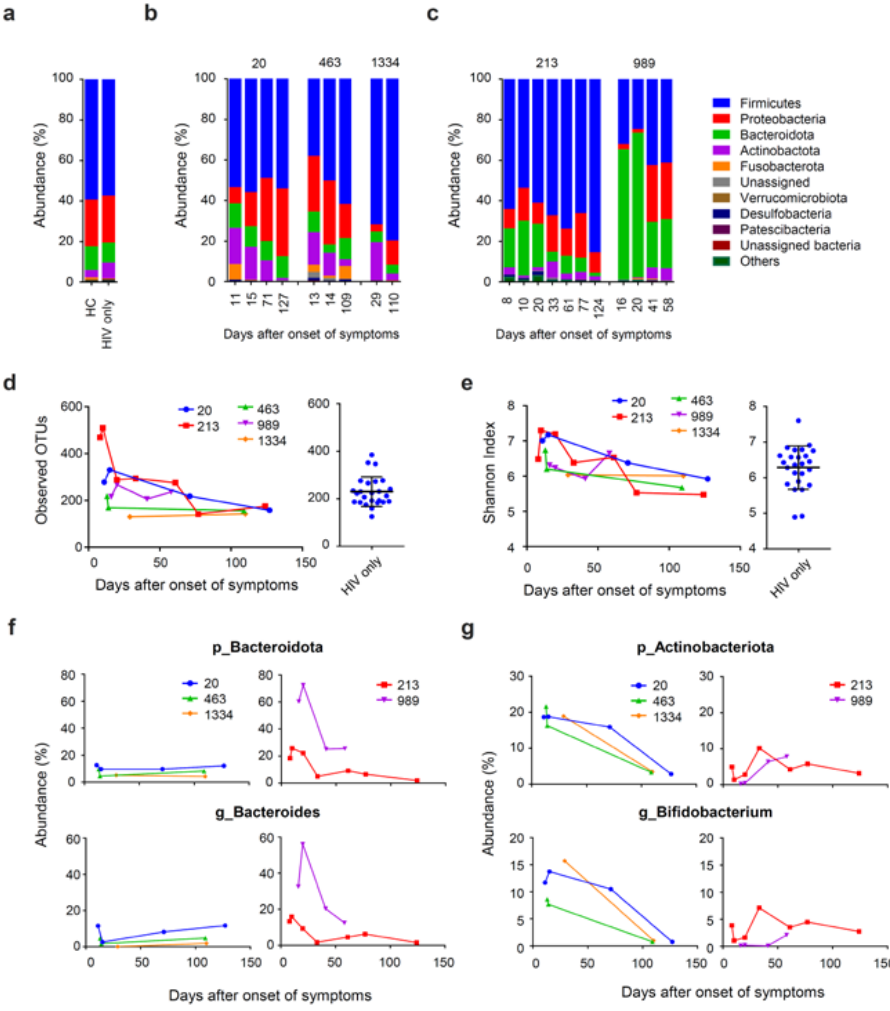
Figure 3. 16S rRNA analysis of changes in the intestinal microbiome of patients after hepatitis A virus (HAV) infection. ( a – e ) Bacterial taxa profile (Phyla) in the gut microbiome of each patient: ( a ) Average of bacterial taxa profile (Phyla) of healthy cohorts (HC), patients with HIV (not with HAV); ( b , c ) the taxa profile (Phyla); ( d ) observed operational taxonomic units (OTUs); ( e ) Shannon index of the gut microbiome of individual patients; and ( f , g ) bacterial taxa profile (Phyla and genus) in the gut microbiome of each patient. The clinical onset was set to day 1. Due to the small number of analyses, statistically significant differences in changes in the gut microbiota could not be confirmed.